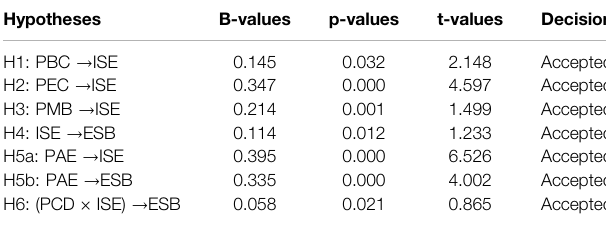
TABLE 5 | Hypotheses testing and speci fi c indirect effects.